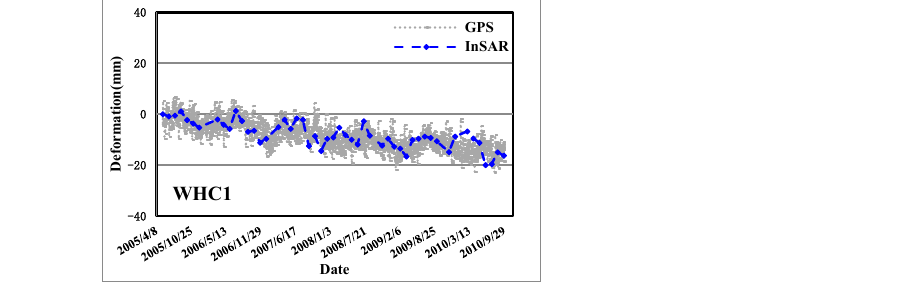
Figure 12. Comparisons of LOS time series from InSAR results (blue dashed line) and GPS monitoring data (grey dot line).